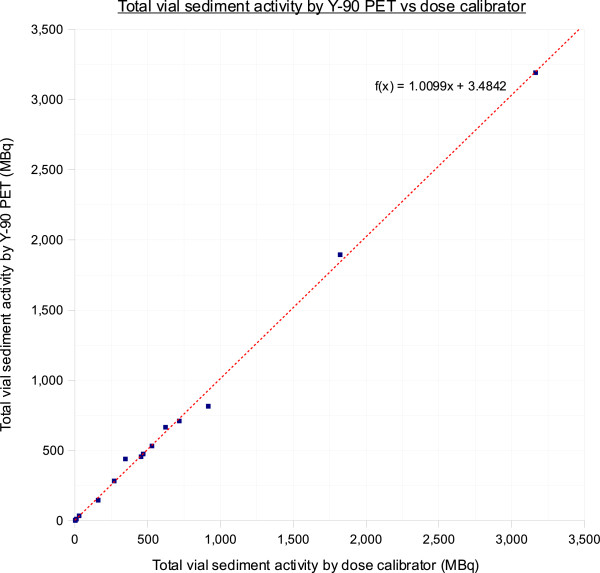
Detector linearity. Linear regression line (dotted) of total vial sediment activities quantified by 90Y PET versus that of a dose calibrator.